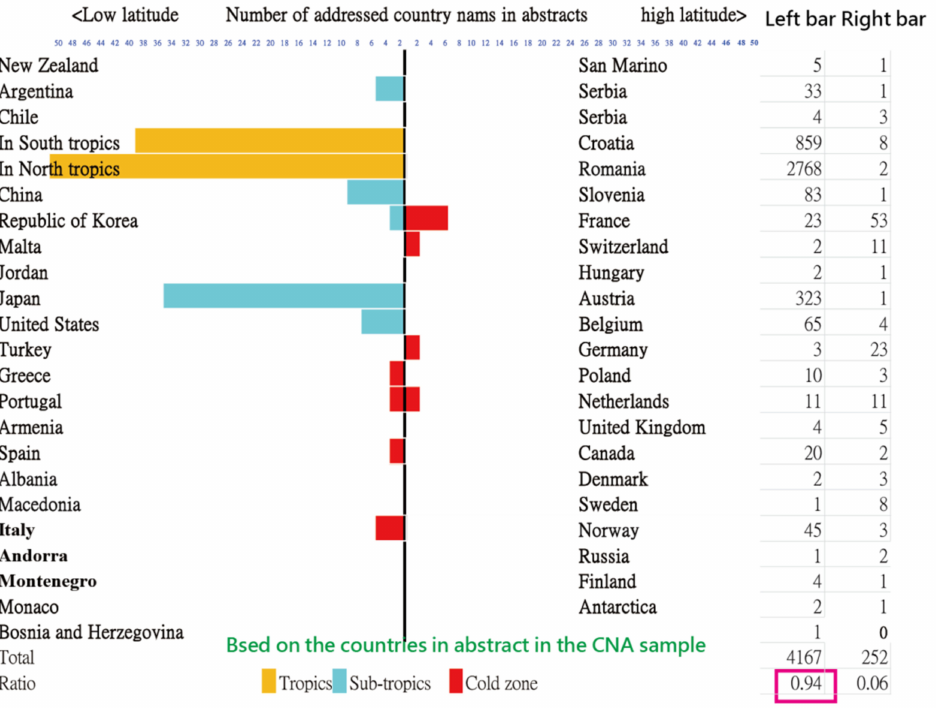
Figure 3. Distribution of dengue articles related to countries/areas; the latitudes of countries/areas are sorted in ascending order from top to bottom, and the bars are matched to the numbers in the columns at the right-hand